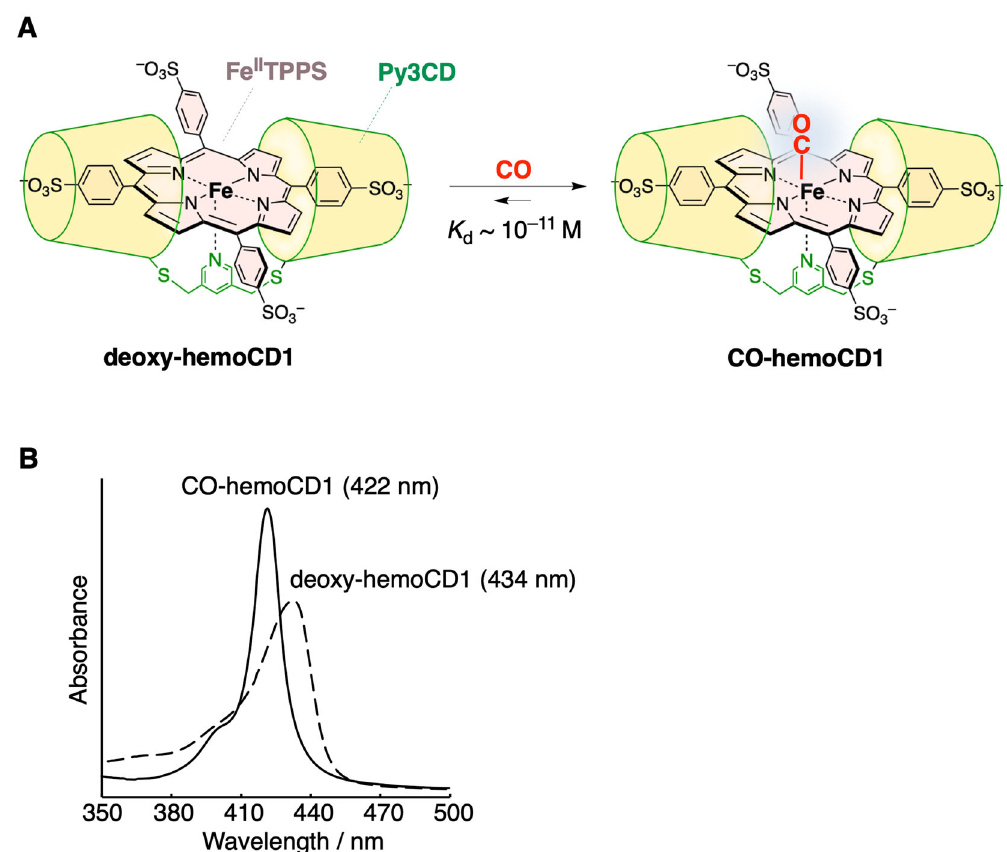
Fig. 1 HemoCD1, a CO detecting agent. A HemoCD1 is composed of 5,10,15,20-tetrakis(4-sulfonatophenyl)porphinatoiron(II) (Fe II TPPS) and a per- O - methyl- β -cyclodextrin dimer having a pyridine linker (Py3CD). The structure of deoxy-hemoCD1 and CO-hemoCD1 complexes is shown. B UV – vis spectra of hemoCD1 showing the Soret bands typical of deoxy-hemoCD1 (434nm) and CO-hemoCD1 (422 nm) in PBS at pH 7.4 and 25